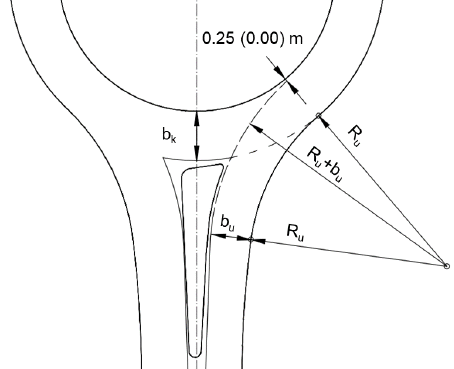
Figure 25. Initial design parameters for single-lane roundabout entry according to [10]. The number and size of the radius of curvature at the right edge of the pavement at the roundabout entry and exit and the design of the transition from the width of the